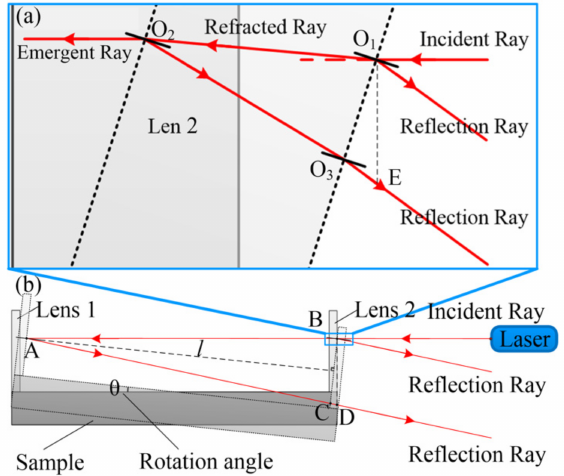
Figure 6. Schematic diagram of the laser transmission after the rotation. ( a ) The laser transmission at the right lens. ( b ) The laser transmission of the measurement system after